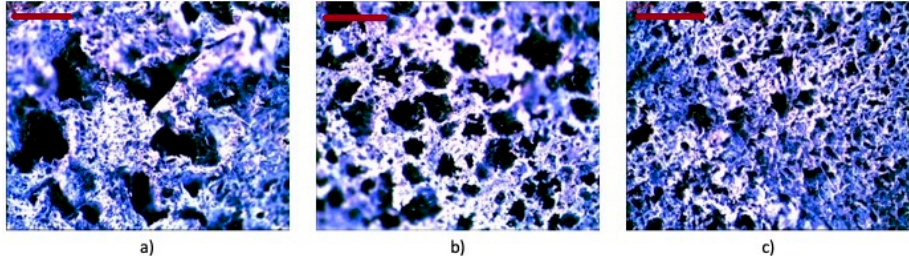
Figure 9. The microscopic images, after approximately 300 × magnification of the RS/8452 ( a ); RS/8180 ( b ), RS/8411 ( c ).